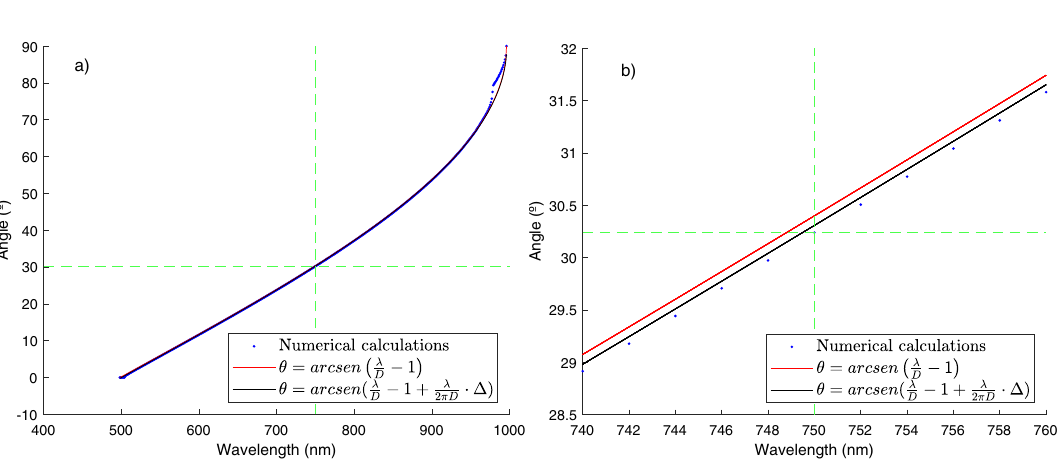
Figure 4. ( a ) Analytical prediction of the equilibrium angle versus wavelength (black line) and value obtained numerically (blue points). The resonant angle is plotted with a red line. In ( b ) a zoom for wavelengths ranging from 740 to 760 nm is shown. Green line marks the expected equilibrium value for a wavelength of 750 nm, close to